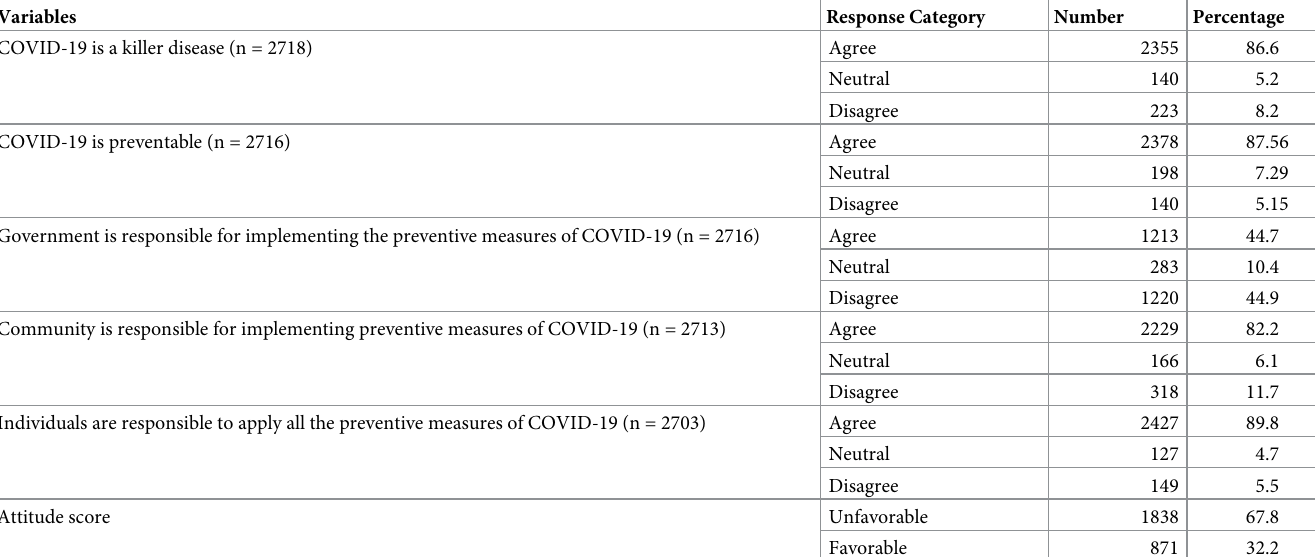
Table 3. Attitudes of the respondents towards COVID-19 preventive measures, Oromia region, Ethiopia, September 2020 to March